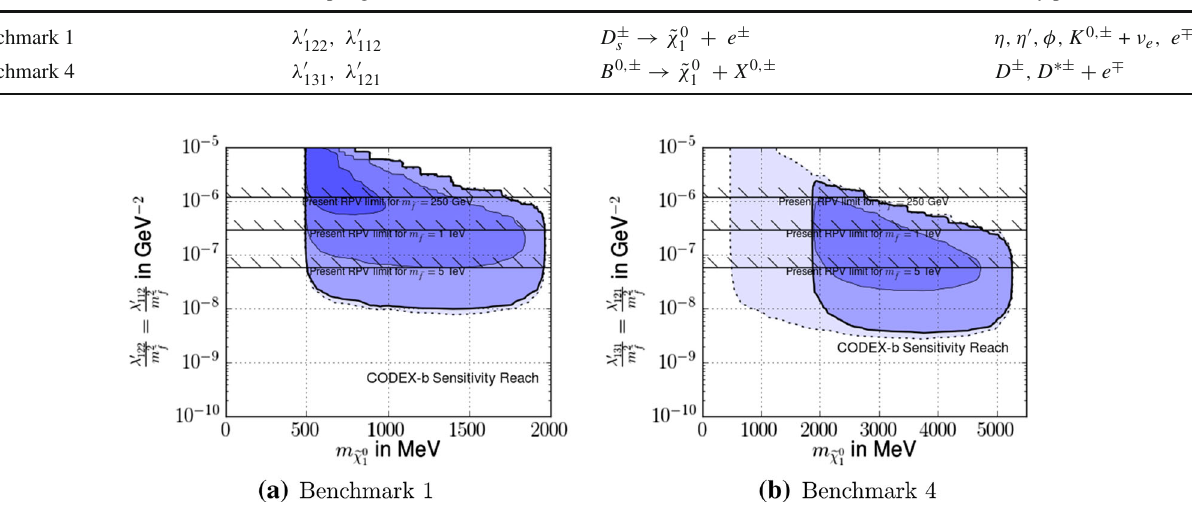
resents the extended sensitivity if one assumes CODEX-b could also detect the neutral decays of the neutralino. The hashed solid lines indi-